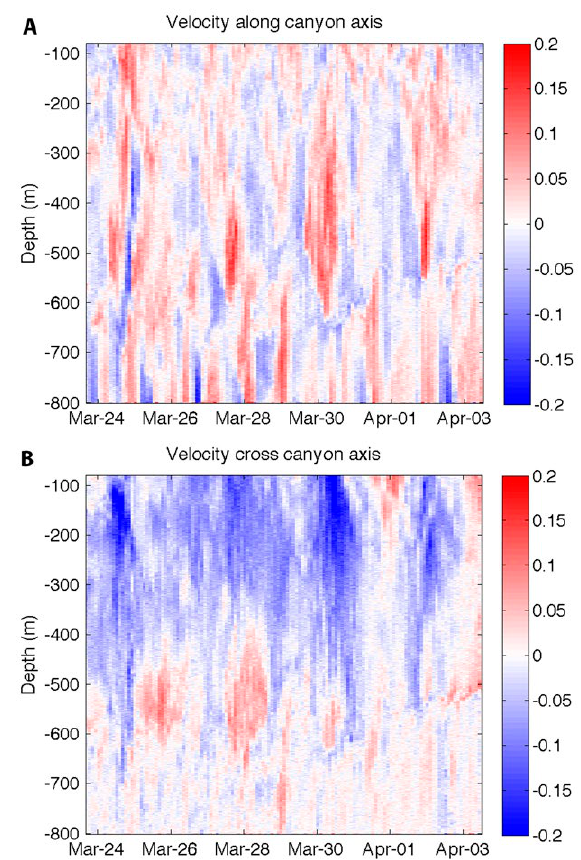
Fig. 4. – Time evolution of velocity (m s –1 ) profiles: A, along-can- yon axis component and B, cross-canyon axis component (positive values are towards NE and